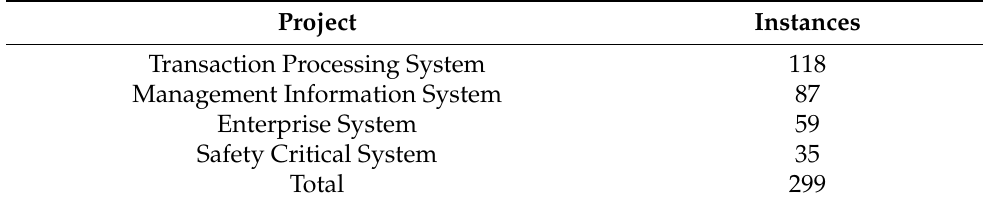
Table 3. Projects and number of instances.